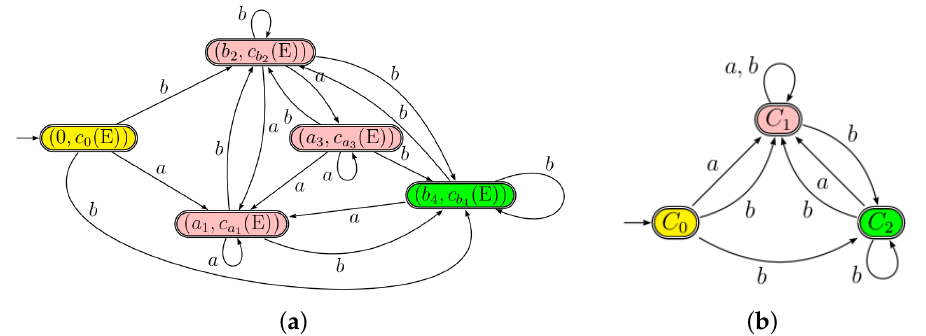
Figure 5. ( a ) The c-continuation automaton C E versus ( b ) The quotient automaton C E / ≡